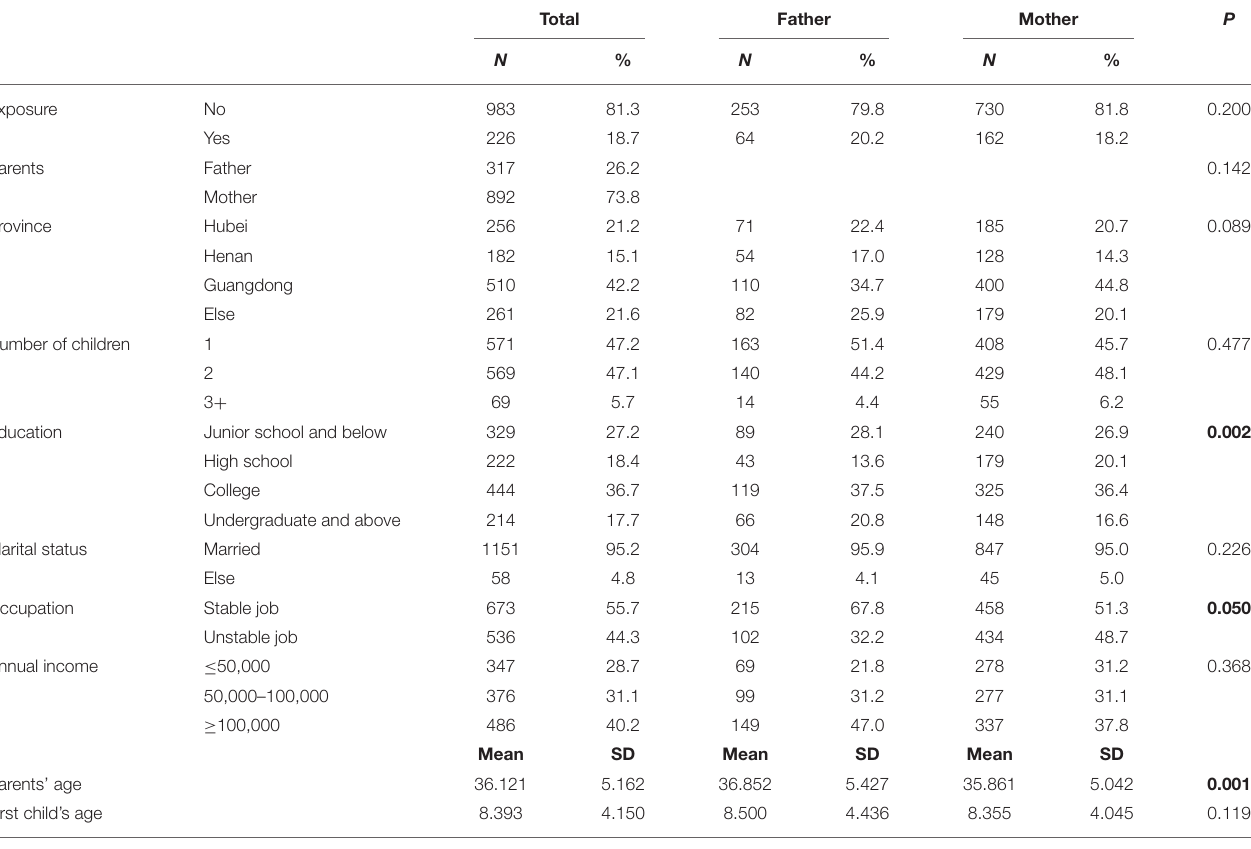
TABLE 1 | Descriptive data on social-demographics ( N = 1,209).